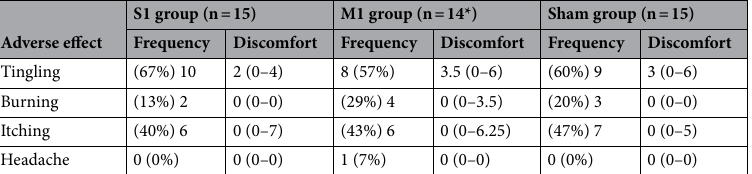
Table 3. Frequency and discomfort of adverse effects. S1/M1 group: high-definition transcranial direct current stimulation over S1/M1, respectively. Median values and interquartile ranges of discomfort are presented. *Data from one subject were not included due to technical loss of